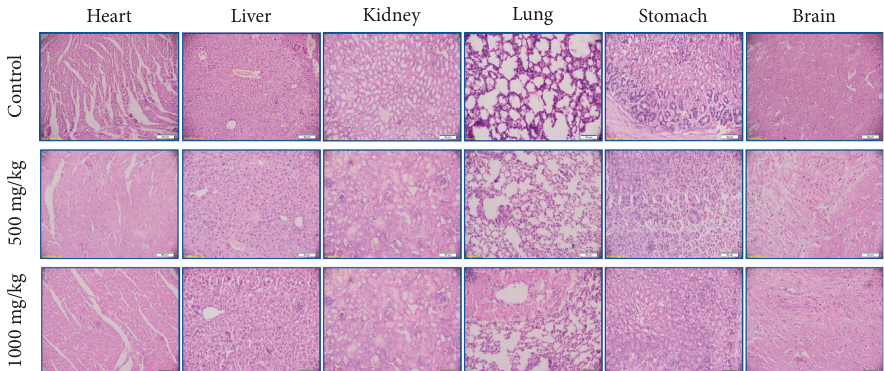
Figure 4: Histological images of heart, liver, kidney, lung, stomach, and brain tissue of A. philoxeroides (500 mg/kg and 1000mg/kg) treated and controlled mice. Sections of the heart, liver, kidney, lung, stomach, and brain tissue were harvested from the female Swiss Albino mice 28 days of A. philoxeroides (500 mg/kg to1000 mg/kg) after treatment. Test samples were processed with hematoxylin and eosin (H and E) stain. Images were taken at 20X magnification. No pathological changes were observed in the case compared to the control. Table 5: Influence of three dosages of A. philoxeroides methanol extract on the blood parameters of mice. Hematological